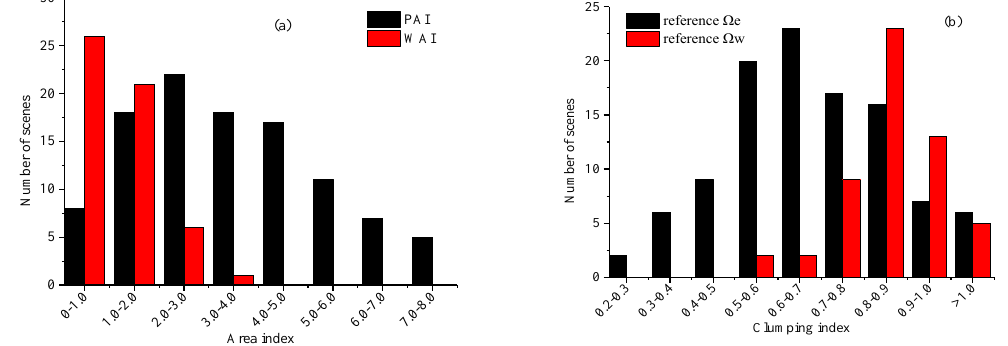
 and  ( b ) of leaf-on e w